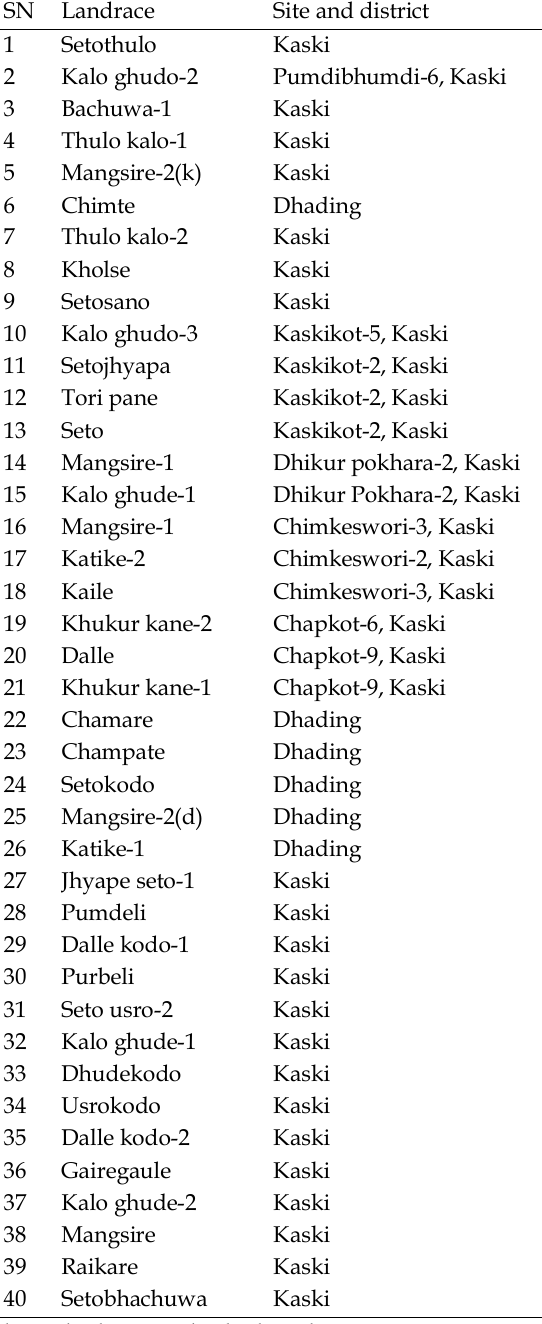
Table 1. Landraces of finger millet collected from different regions for this